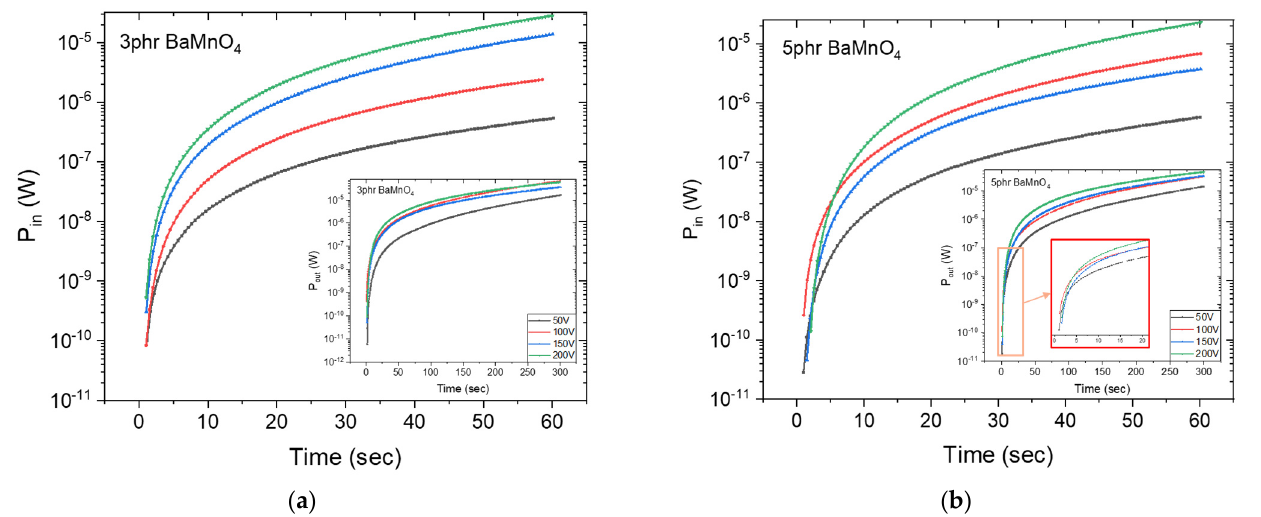
Figure 6. Stored power (P in ) of ( a ) 3 phr BaMnO 4 and ( b ) 5 phr BaMnO 4 specimens as a function of time. Insets depict the retrieved power (P out ) as a function of time of 3 phr BaMnO 4 and 5 phr BaMnO 4 specimens, respectively.